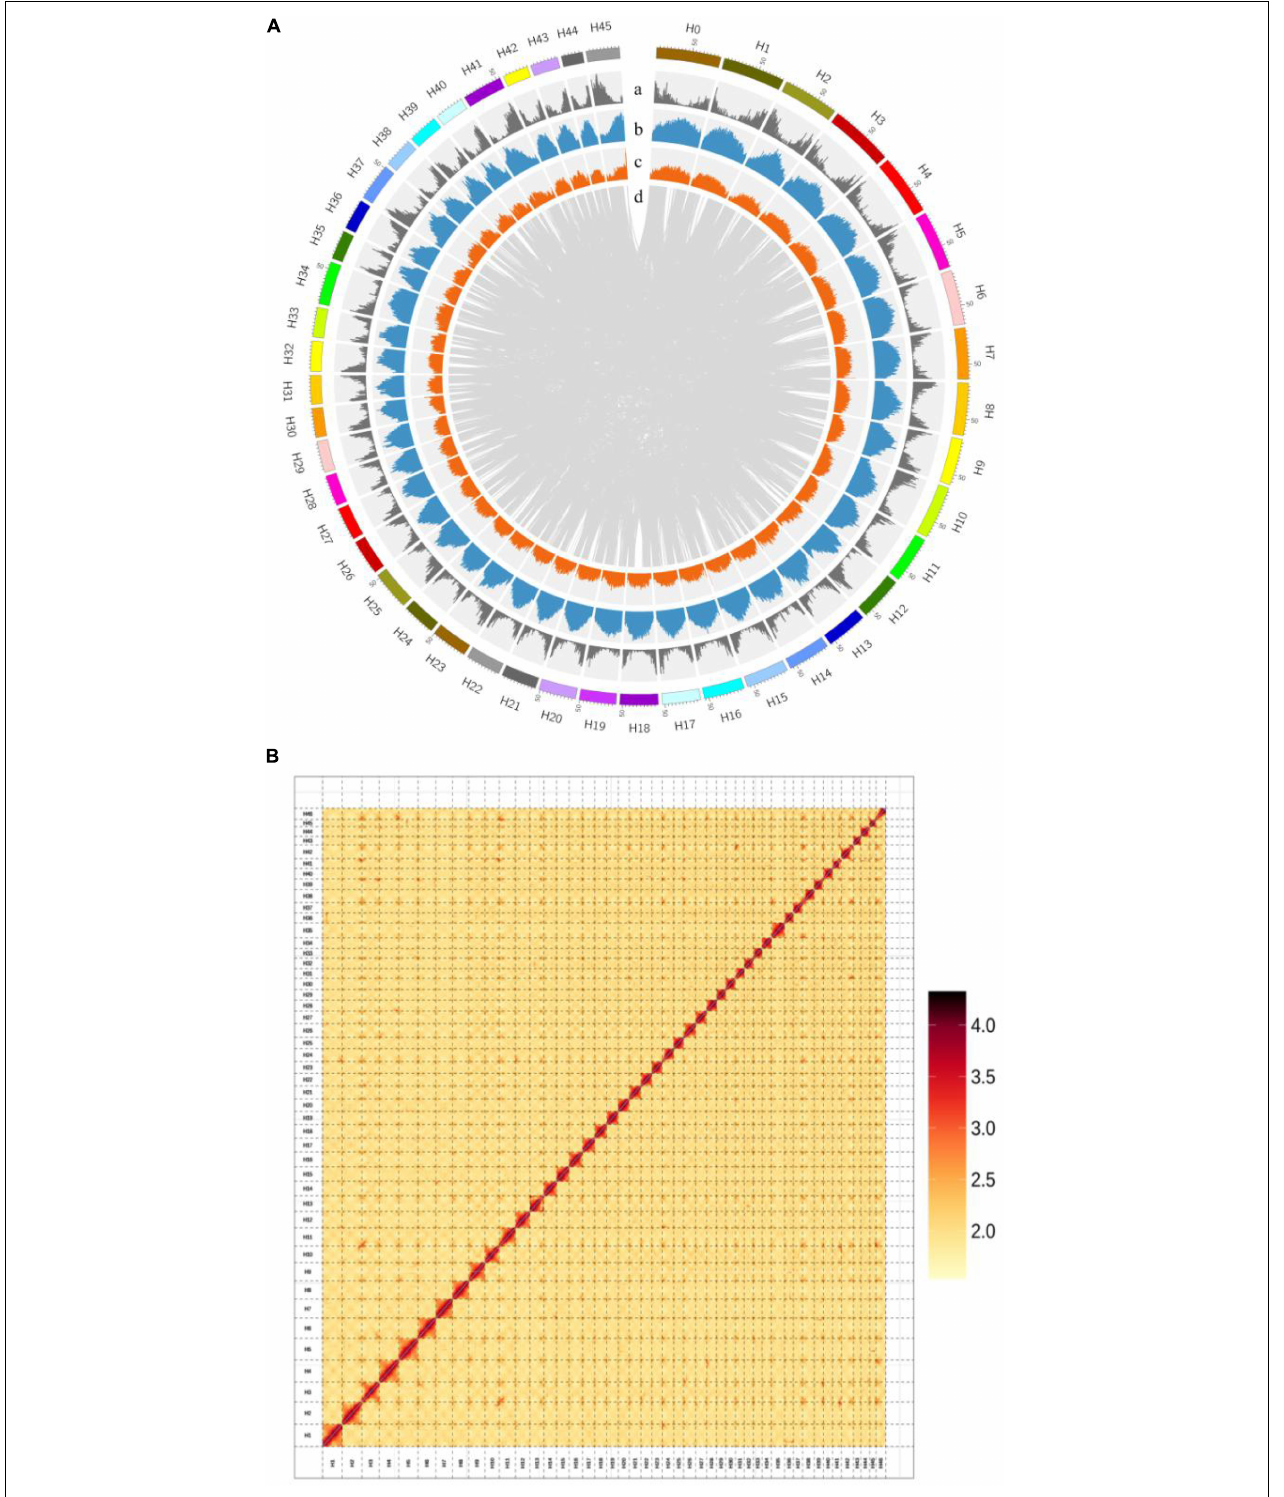
FIGURE 3 | (A) Chromosomal features of H. mutabilis . (a) Gene density; (b) Repeat density; (c) AT content; (d) Syntonic blocks. (B) Hi-C map of the H. mutabilis genome showing genome-wide all-by-all interactions. The map shows a high resolution of individual chromosomes that were scaffolded and assembled independently. Color intensity indicates the frequency of Hi-C interaction links from low (yellow) to high (red).